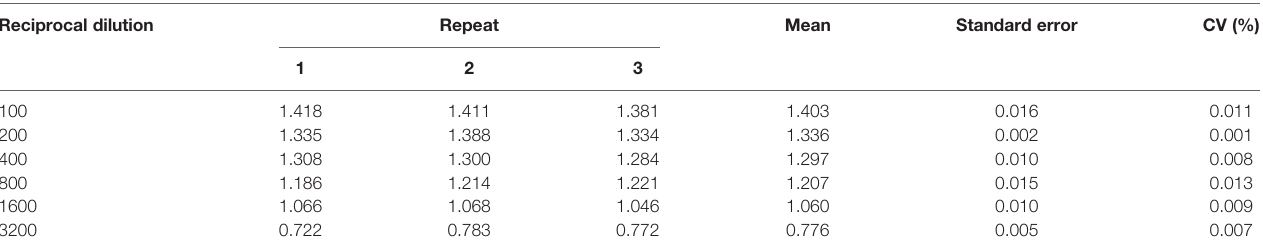
TABLE 1 | Intra- batch